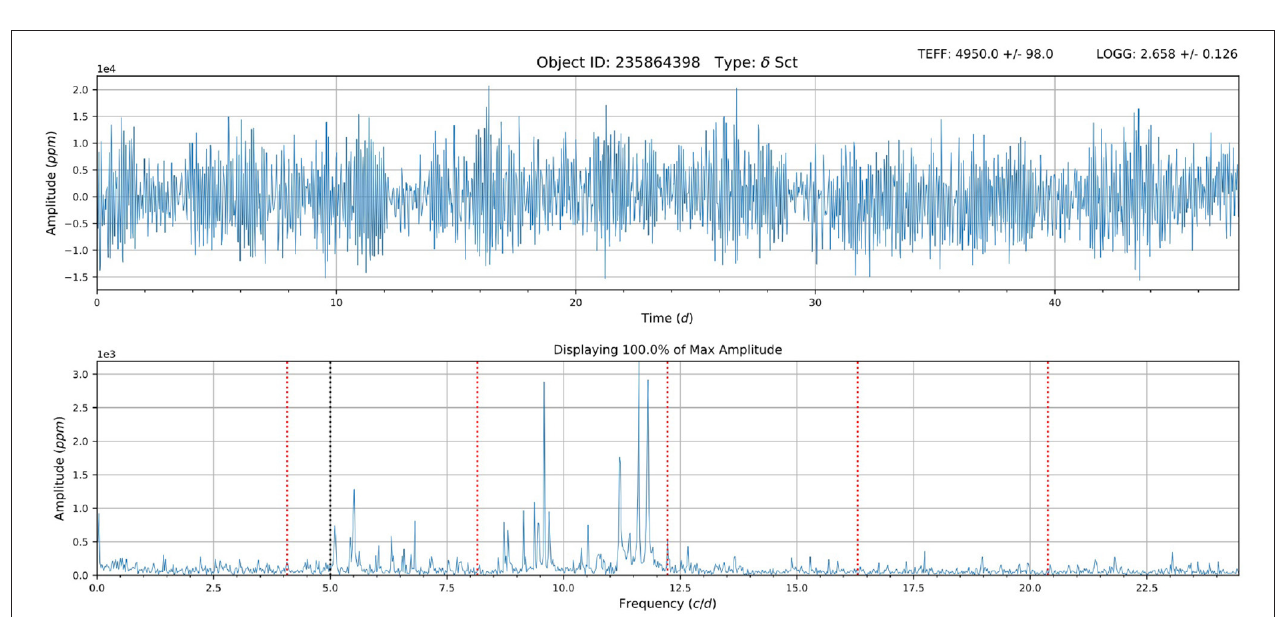
FIGURE 7 | Light curve (Top) and amplitude spectrum (Bottom) for hottest δ Sct candidate, EPIC 233466131, observed during C11.